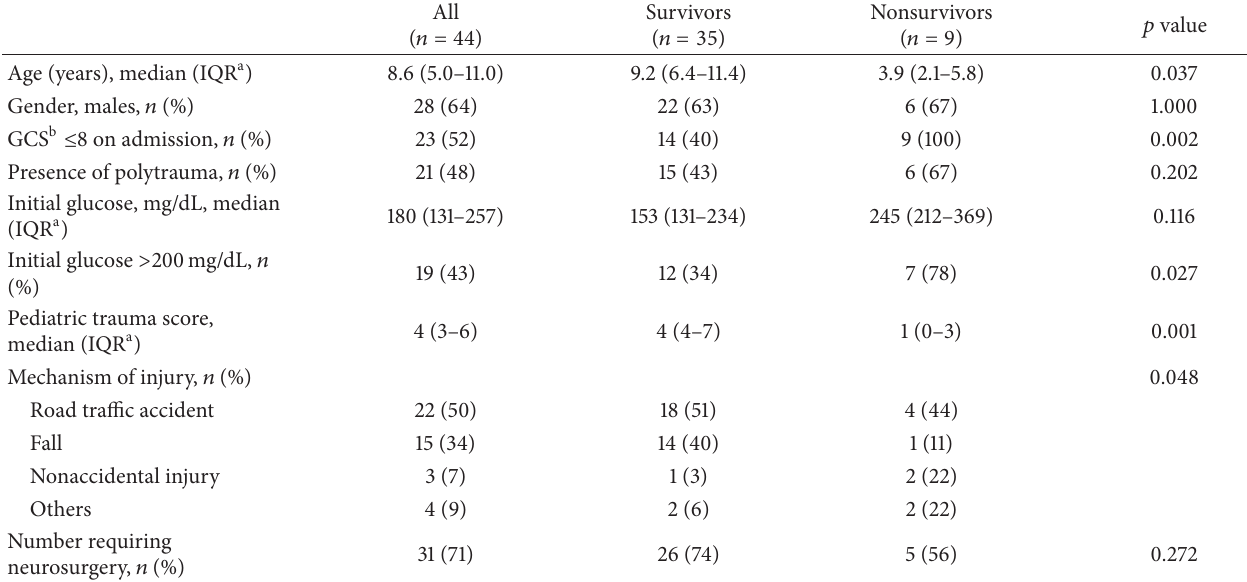
Figure 1: Flow chart of cohort of children with moderate to severe traumatic brain injury. Table 1: Clinical demographics and mechanism of injury for both survivors and nonsurvivors with moderate and severe traumatic brain